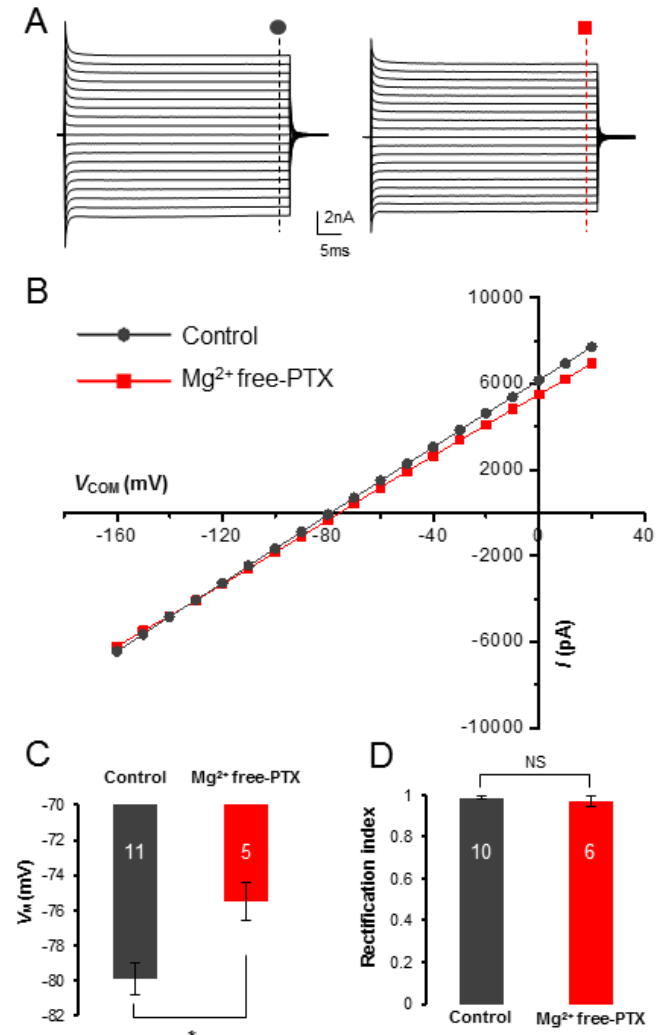
Figure 3. Epileptiform neuronal discharges do not induce changes in astrocyte passive conductance but depolarizes astrocytes. ( A , B ) The passive membrane conductance was not altered by Mg 2+ free-PTX treatment, in terms of current amplitude and the linearity in current-voltage (I- V M ) plot. ( C ) The Mg 2+ free-PTX perfusion depolarized astrocyte V M by 4.4 mV compared to control group